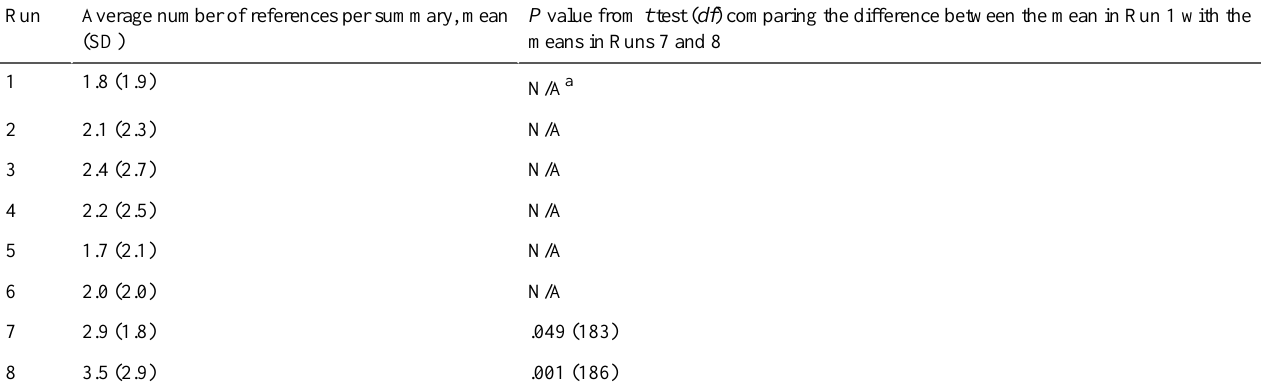
Table 7. The average number of references per final summary assignment. 8Average number of references per summary, mean